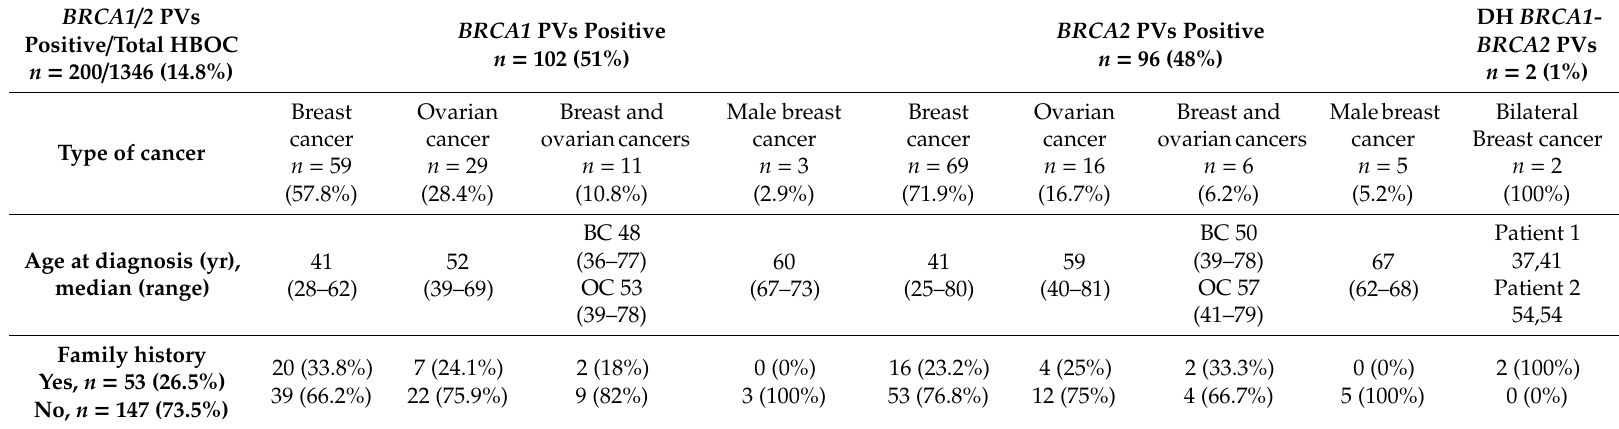
Table 1. Number of patients with Hereditary Breast / Ovarian Cancer (HBOC) and BRCA1 / 2 pathogenic variants (PVs) (1999–2019), type of tumors (breast cancer, ovarian cancer, breast and ovarian cancers, male breast cancer), median age at diagnosis and family